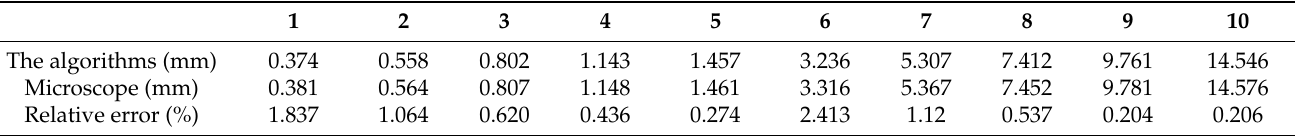
Table 4. The comparison results of crack length.